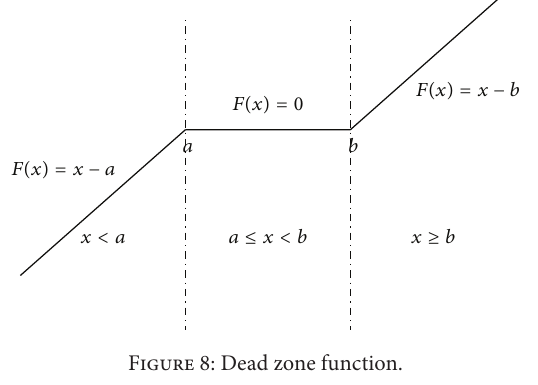
Figure 8: Dead zone function.